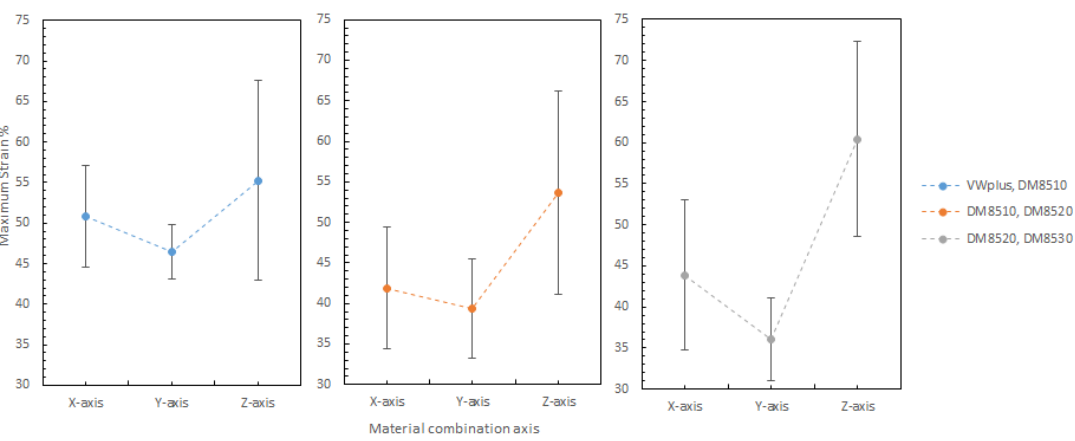
Figure 30. Combination axis effect on ultimate tensile strength (UTS) at 25 degree Celsius.